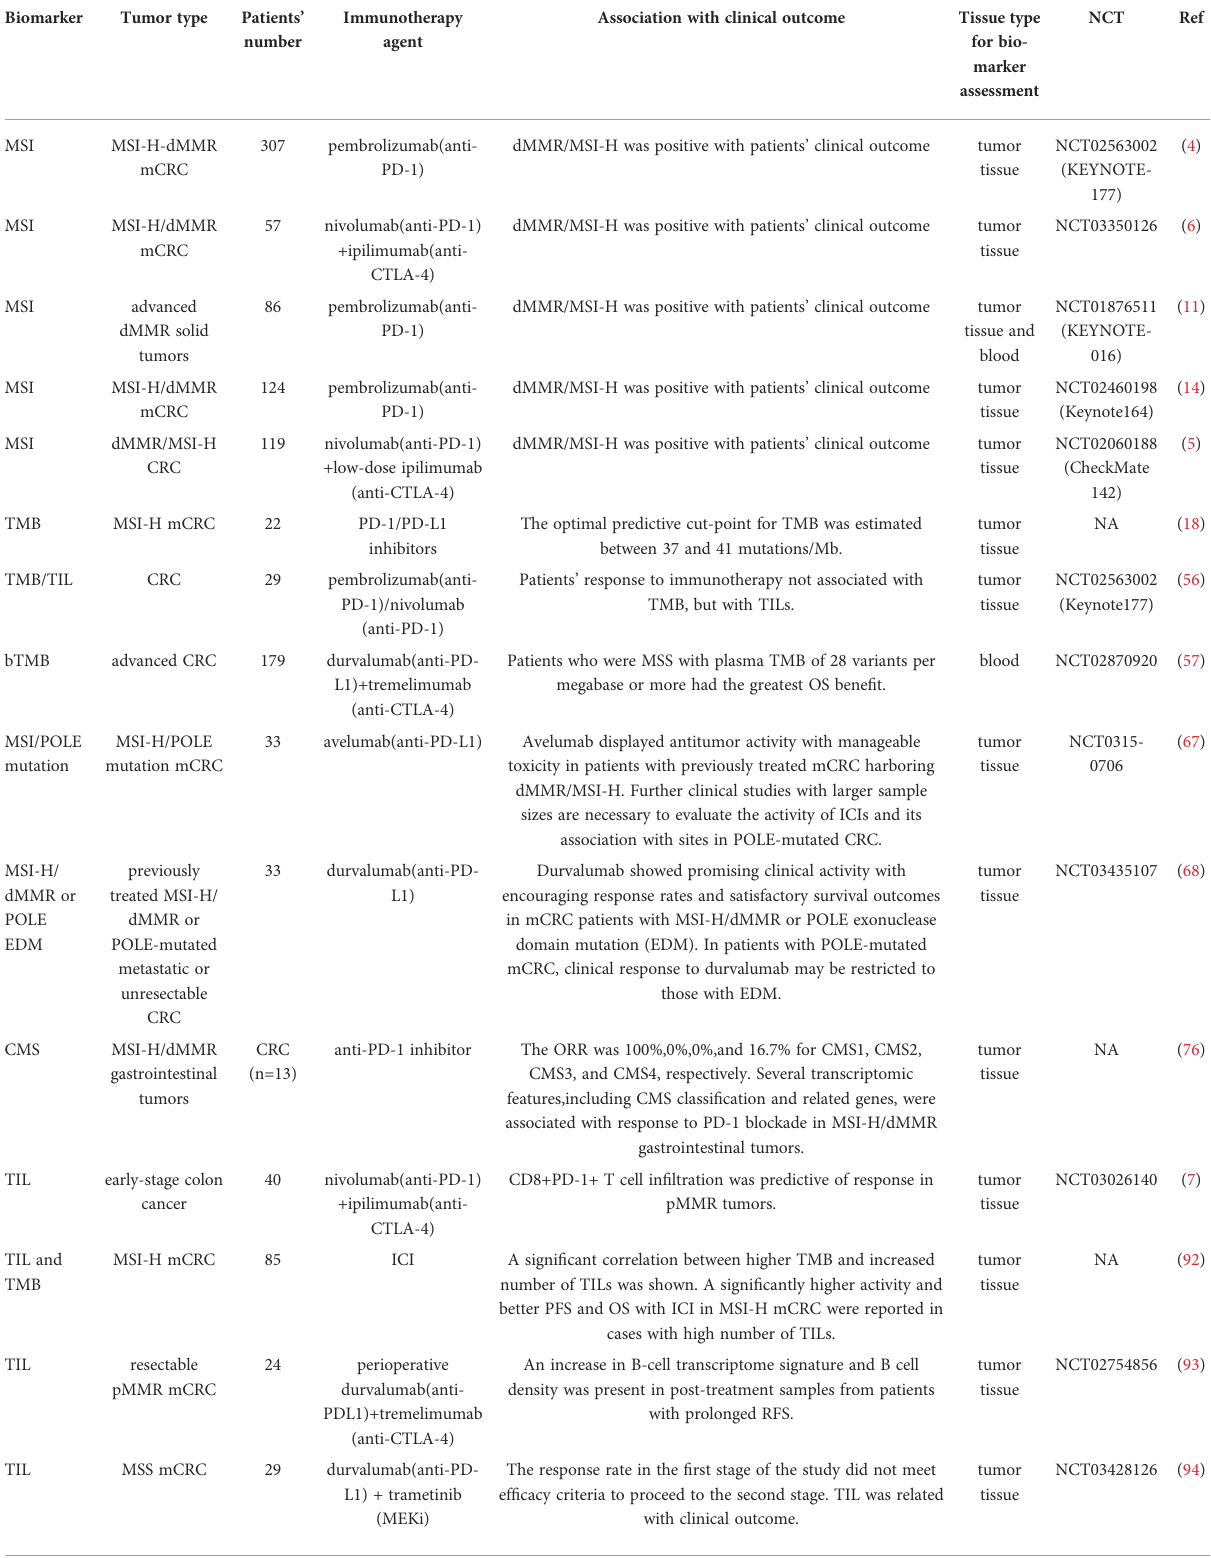
TABLE 1 Summary of biomarkers for colon cancer immunotherapy in reported clinical